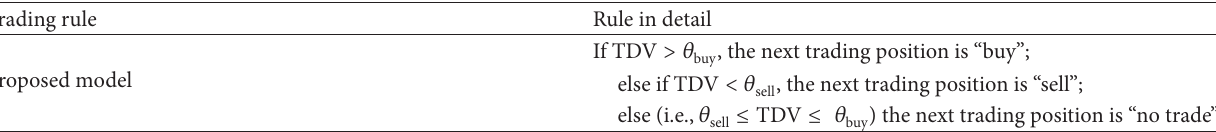
Table 5: Trading rule design of proposed model.